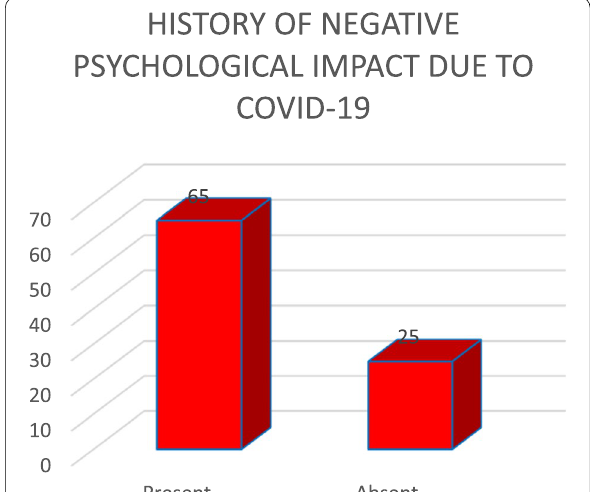
Fig. 3 History of negative psychological impact due to